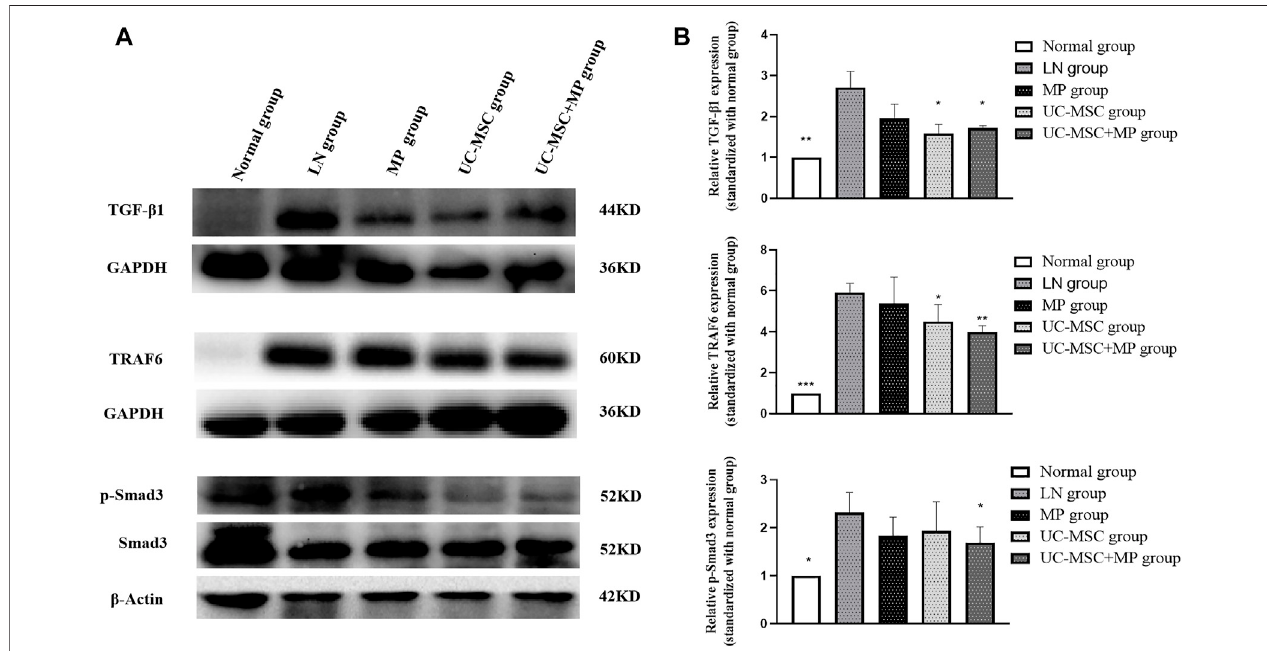
FIGURE 4 | Protein expression of TGF- β 1, TRAF6, and p-Smad3 in renal tissues. Western blot results of TGF- β 1, TRAF6, and p-Smad3 expression of in renal tissues. (A) Western blot results of TGF- β 1, TRAF6, and p-Smad3. (B) Comparison of TGF- β 1, TRAF6, and p-Smad3 protein expression vs. LN group: * p < 0.05; ** p < 0.01; *** p < 0.001.